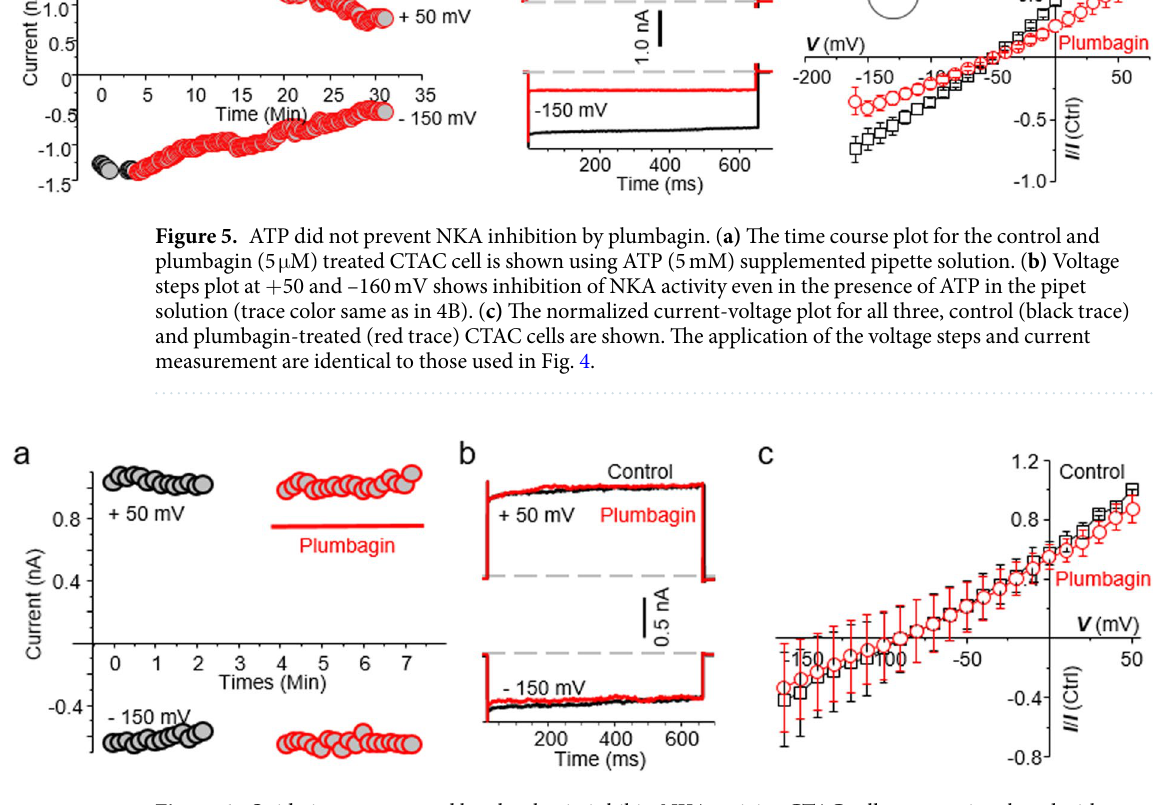
Figure 6. Oxidative stress caused by plumbagin inhibits NKA activity. CTAC cells were preincubated with 2 mM of NAC for 1 hour. Healthy cells were patch clamped before and after treatment with plumbagin (5 μ M). ( a) Time course plot of the control and plumbagin treated cell is shown measured at + 50 and –150 mV. ( b) Current measured in response to voltage steps of + 50 and − 150 mV is shown. ( c) Average current-voltage plots (n = 5) for the control (black trace) and plumbagin (5 μ M) treated (red trace) CTAC cells are shown. The voltage pulses applied and color scheme are identical to those described in (Fig.